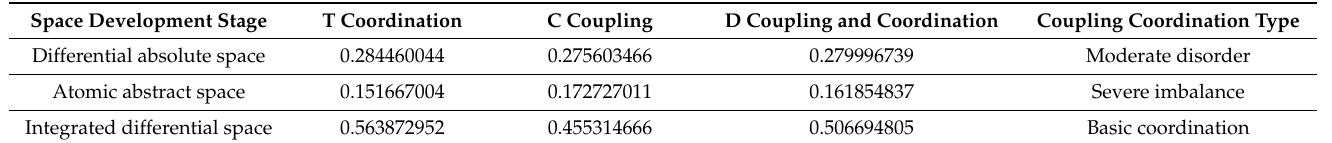
Table 2. Coupling and coordination degree of space production in the danwei